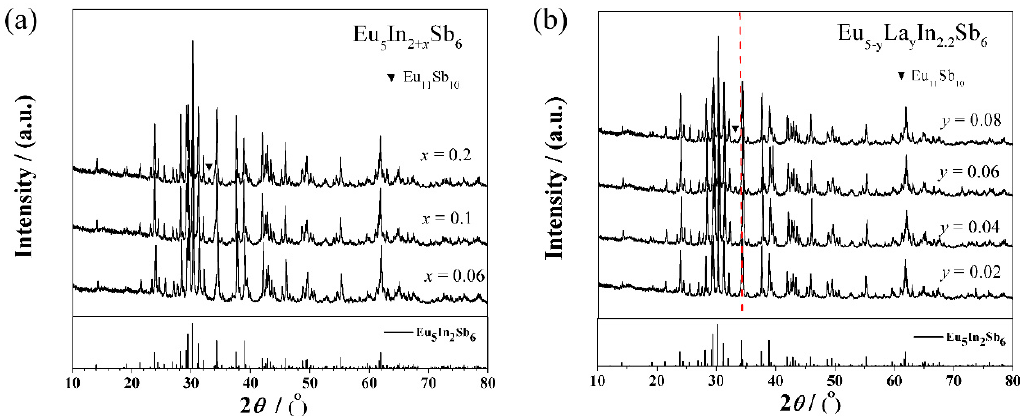
Figure 2. PXRD patterns for samples ( a ) Eu 5 In 2+ x Sb 6 ( x = 0, 0.06, 0.1, 0.2) and ( b ) Eu 5 − y La y In 2.2 Sb 6 ( y = 0.02, 0.04, 0.06, 0.08).